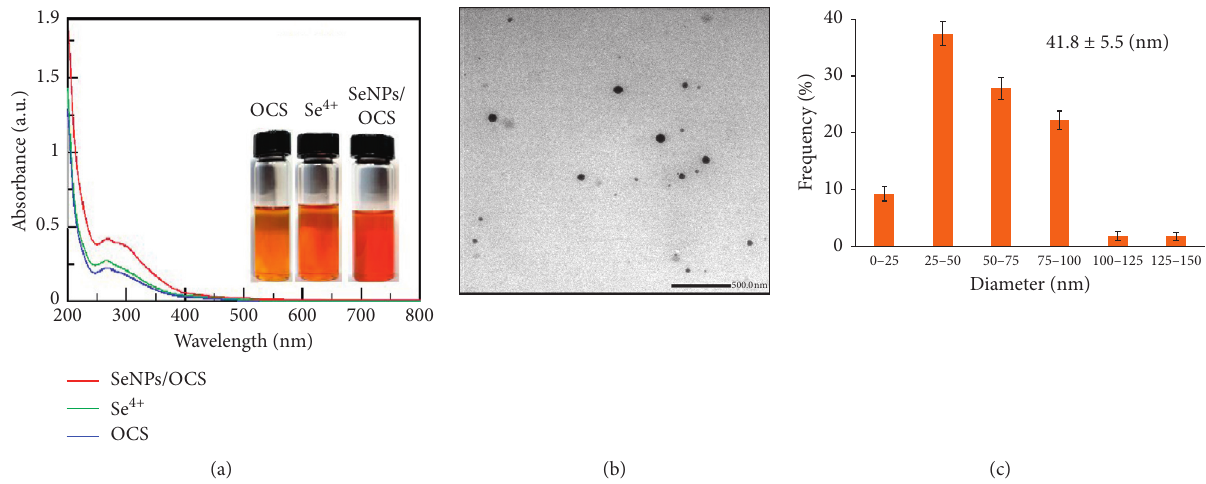
Figure 1: UV-Vis spectra of OCS, selenium ion, and a SeNP/OCS solution (a), TEM image (b), and the size distribution of a SeNP/OCS solution (c).